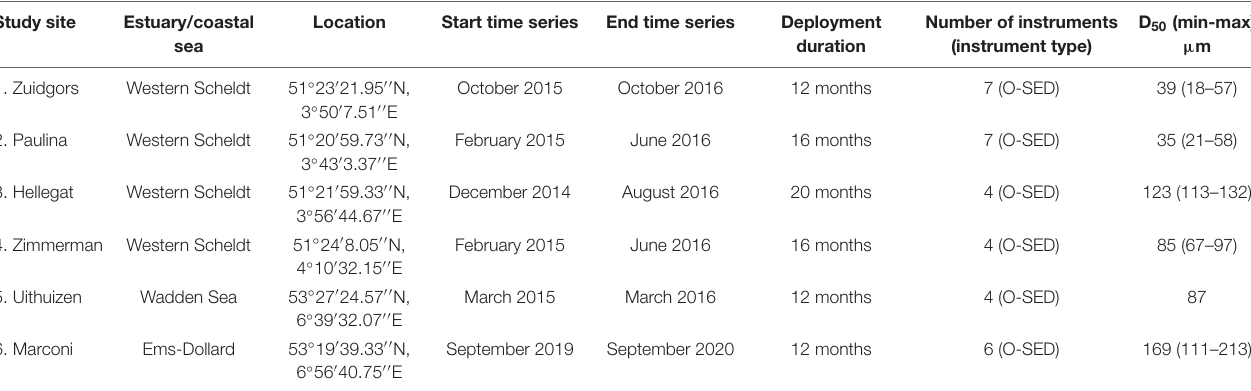
TABLE 1 | Collection of bed level dynamics data using O-SED and A-SED sensors. Study